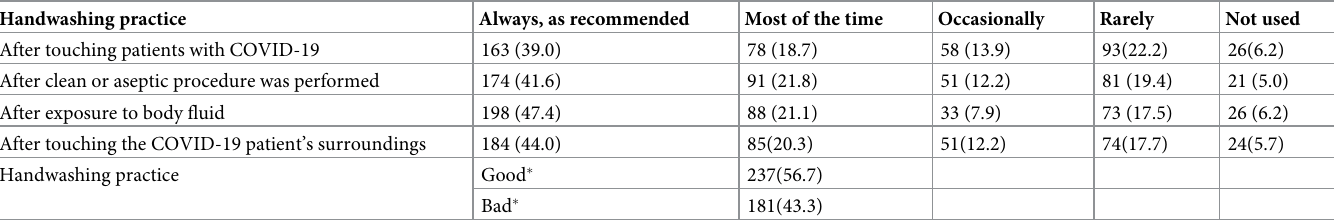
Table 4. Adherence to handwashing practice during health care interactions in the Amhara region, 2020 (N = 418). Handwashing